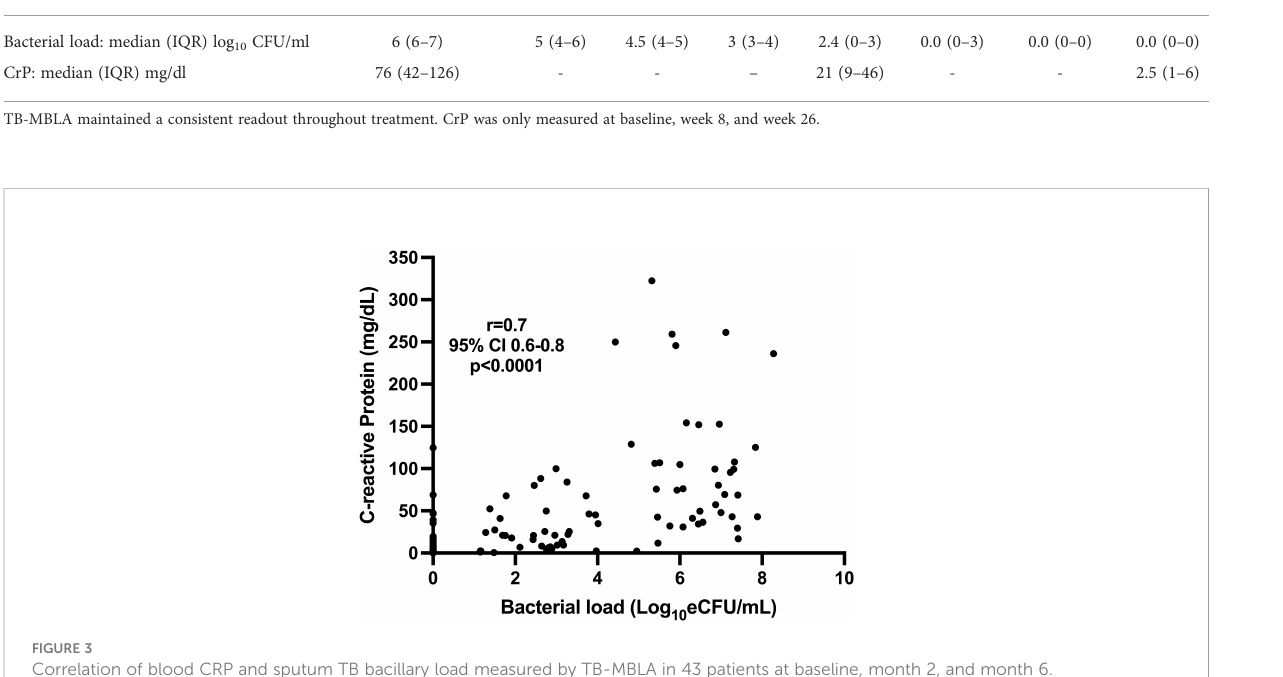
TABLE 3 The fall in TB bacillary load and CrP over treatment course.